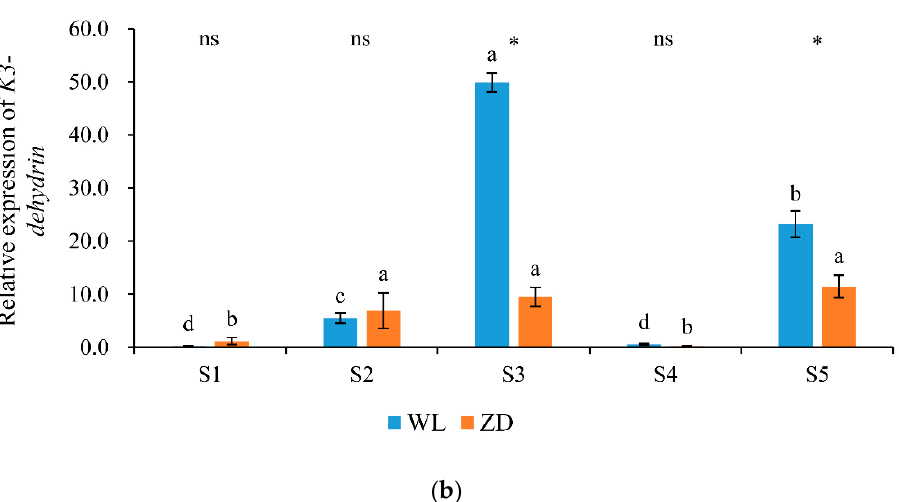
Figure 6. Relative expression levels of cold-regulated genes at five sampling points. Mean values ( n = 4) ± standard errors of the mean are shown. Different letters (a, b, etc.) above bars indicate a significant difference among the five sampling points (from S1 to S5) in one cultivar ( p < 0.05). The asterisk indicates a significant difference between the cultivars (S1 vs. S1, S2 vs. S2, etc.) at one same sampling point ( p < 0.05), and the ‘ns’ indicates no significant difference. S1 to S5 are the sampling points after the five phases of the temperature-controlled treatment regime: in phase 1 the temperature was maintained at 18 °C, in phase 2 it decreased to 2 °C, in phase 3 it was maintained at 2 °C and − 2 °C for two weeks, in phase 4 it increased to 18 °C, and in phase 5 it decreased to 2 °C. ( a ) Cas15A ; ( b ) K3-dehydrin . WL = WL440HQ, ZD = ZhaoDong.